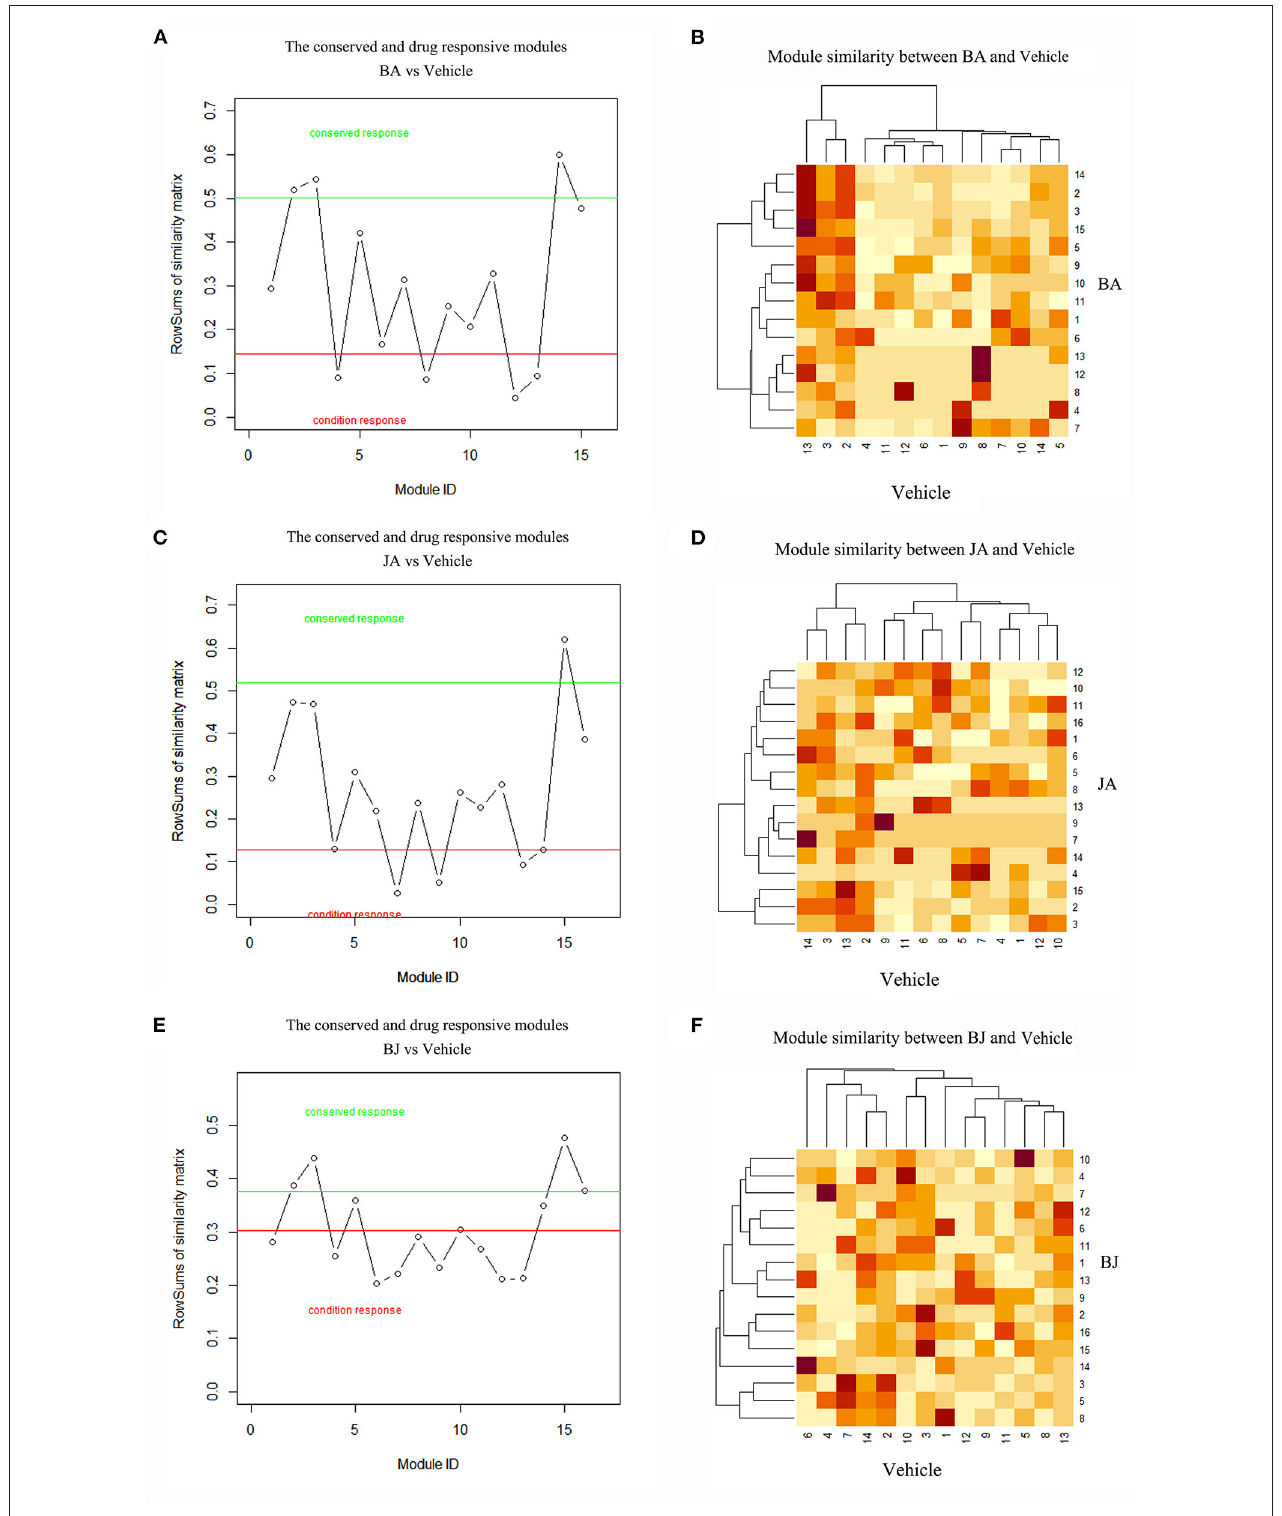
FIGURE 2 | The On-modules and conserved modules of three-drug groups compared with Vehicle. (A,B) BA vs. Vehicle group, the red line represents the threshold of max(s)- θ 2 and green line represents the threshold of min(s) + θ 1, modules under the red line were BA’s On-modules, and modules above the green line were BA’s conserved modules. The heatmap showed the similarities between BA and Vehicle modules. (C,D) JA vs. Vehicle group. (E,F) BJ vs. Vehicle group.